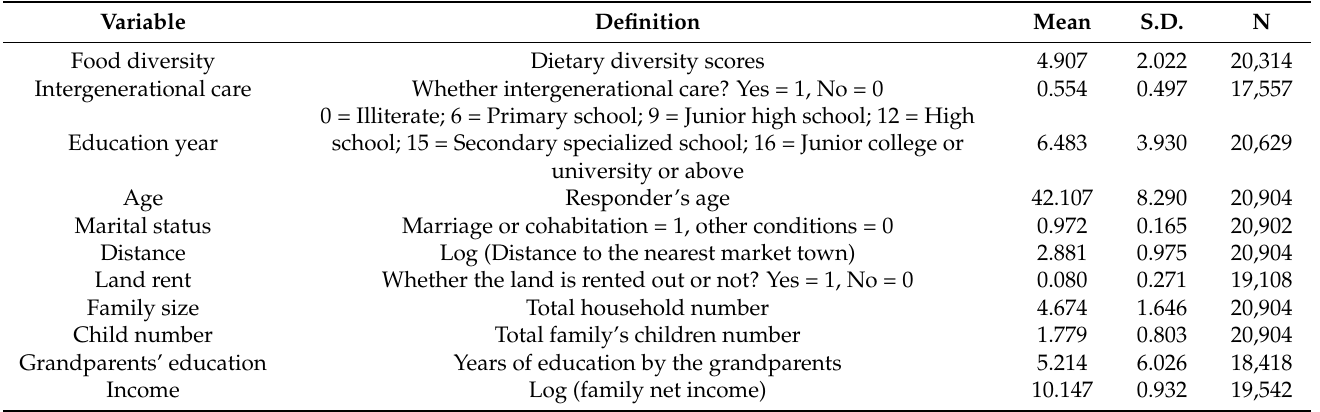
Table 1. Definition and data descriptive